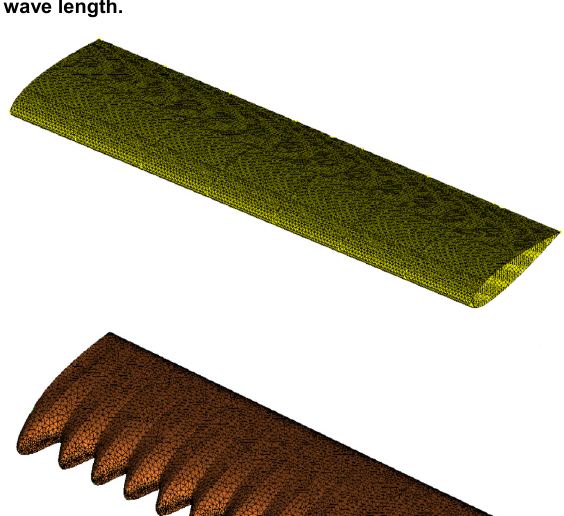
Figure 4. Sinusoidally shaped blade geometry showing wave length.